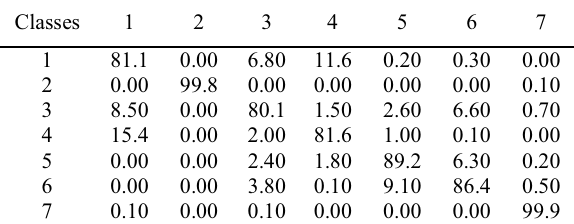
Table 1: Confusion matrix showing percentage of correct classification among different forest type classes classified using